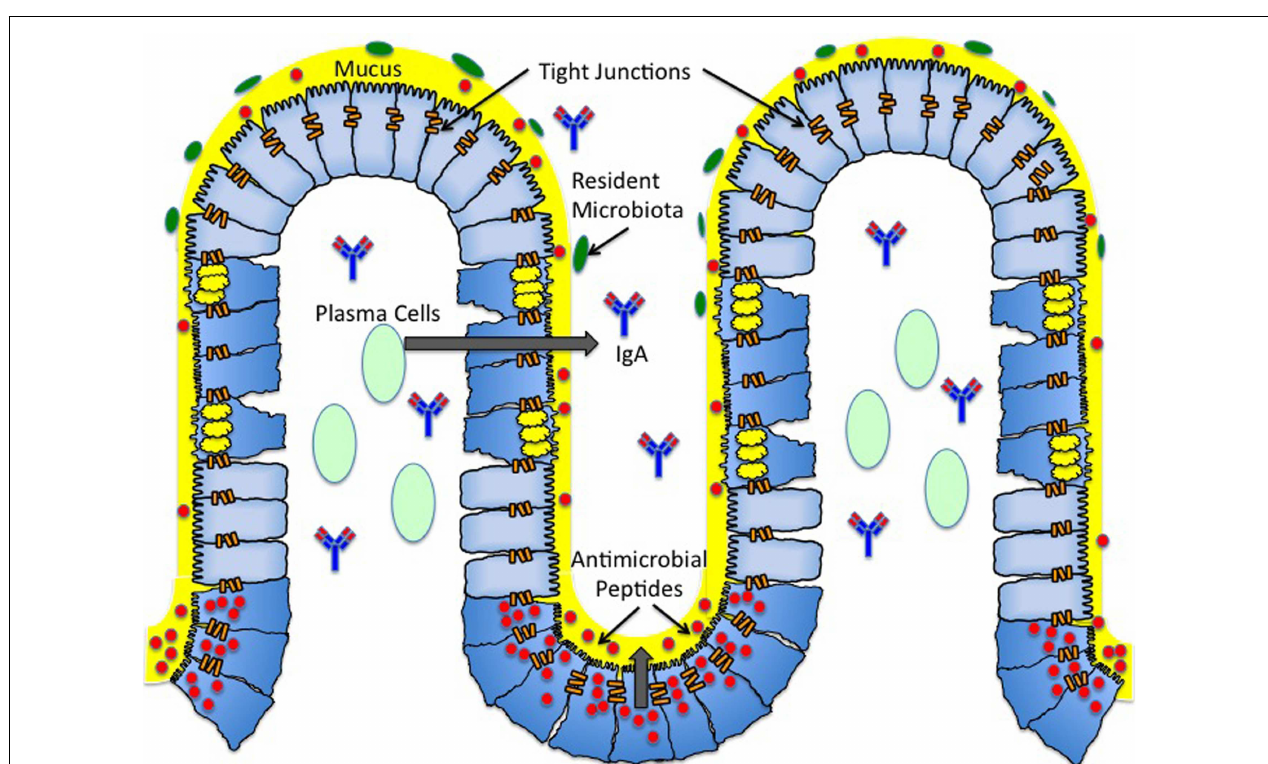
B cells ( light green ) reside in the subepithelial region and produce secretory IgA ( blue and red antibody ). Secreted IgA is found in the subepithelial region and the lumen. Resident microbiota ( green ) reside in the outer mucus layer, providing yet another barrier to pathogenic infection.The majority of resident microbiota belong to two phyla – Firmicutes and Cytophaga – Flavobacterium – Bacteroidetes .The seal between epithelial cells is maintained by tight junctions ( orange bars ).Tight junctions are dynamic structures composed of zonula occludens and junctional adhesion